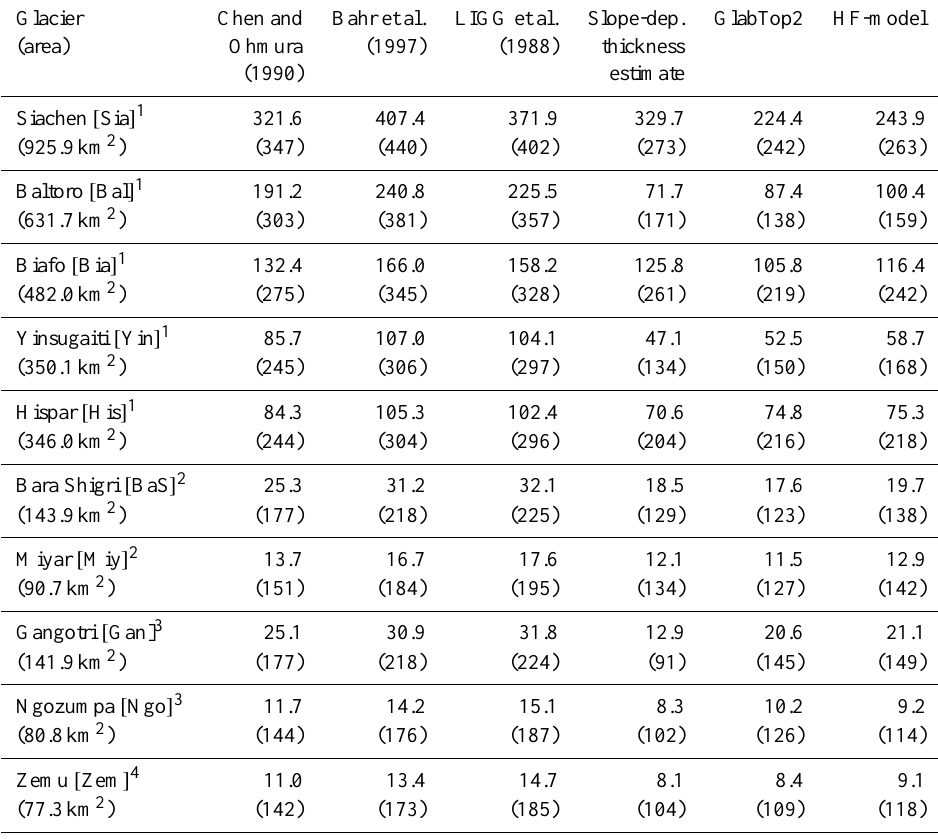
Table 4. Volumes (km 3 ) and mean thickness (m) in brackets of the largest glaciers of each sub-region. Locations of glaciers are indicated in Fig. 1 (abbreviations given in squared brackets after the glacier name).